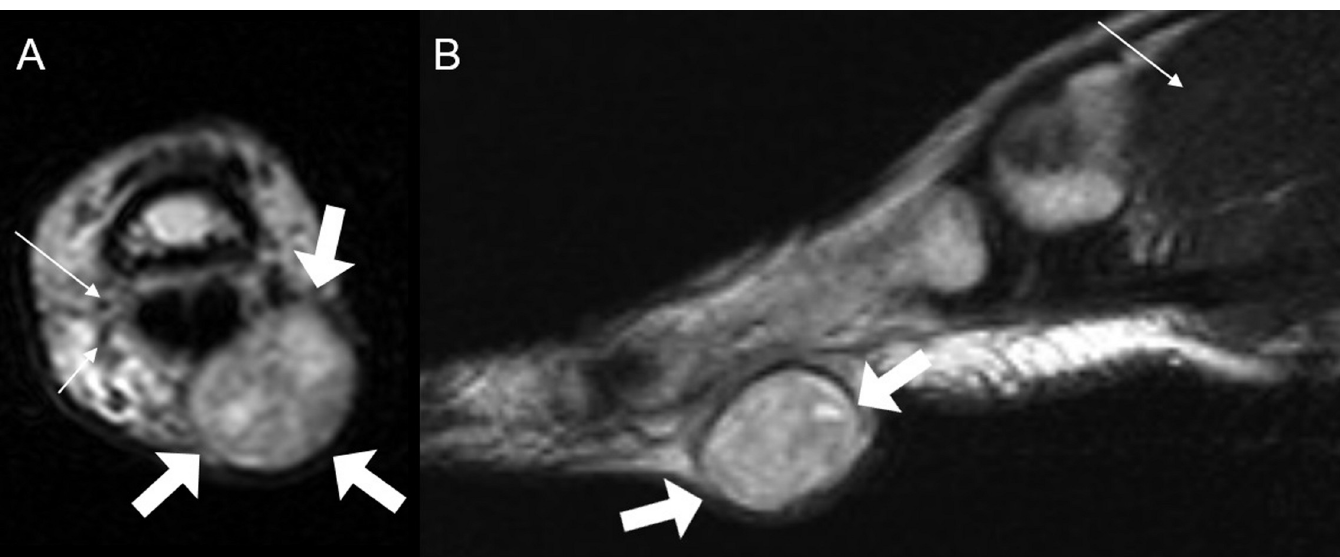
Fig 1. A 31-year-old man with digital schwannoma on the volar side of the 2 nd proximal phalanx of the hand. ( A) On axial T2-weighted image, the mass shows multiple, small, low signal-intensity foci in a background of hyperintensity, representing the fascicular sign (thick arrows). The mass involves the digital neurovascular bundle. A normal palmar digital artery (long thin arrow) and normal palmar digital nerve (short thin arrow) are shown for comparison. ( B) On sagittal T2-weighted image, the mass shows fascicular sign (thick arrows) in a background of hyperintensity compared to the skeletal muscle (thin arrow).